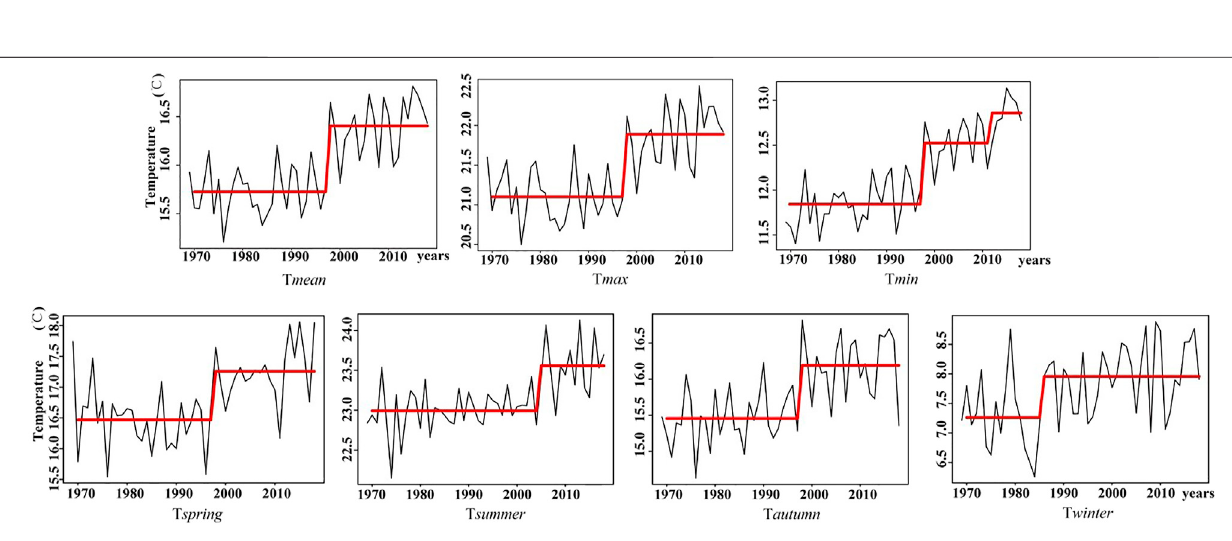
FIGURE 5 | Change-points for annual and seasonal NSATs in Southwest China for the period 1969 – 2018 ( p -value < 0.05).